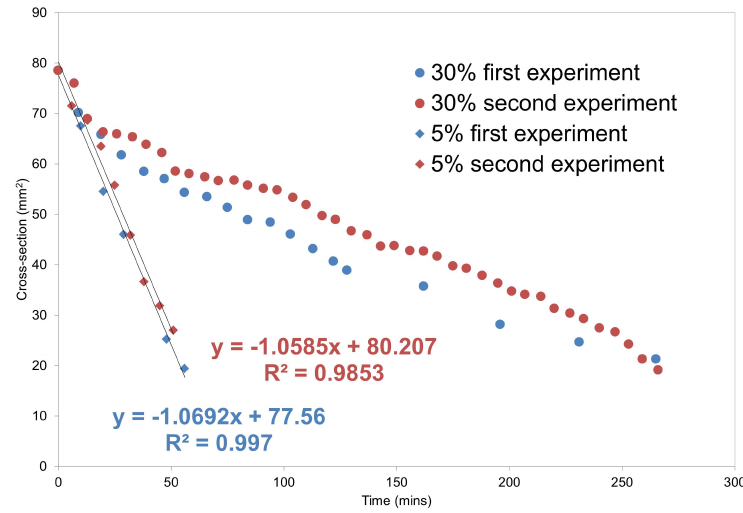
Figure 6. Evolution of the compact dimensions as a function of time for the 5% extrudate and 30% extrudate. Linear best fit to the data for the 5% extrudate is included. For the 30% extrudate, to facilitate the comparison with the 5% extrudate, the dimensions of the compact core (solid material) without considering those of the hydrated layer were measured. Data were collected only up to approximately 300 min due to the compact falling off from the support and being out of the instrumental field of view after this